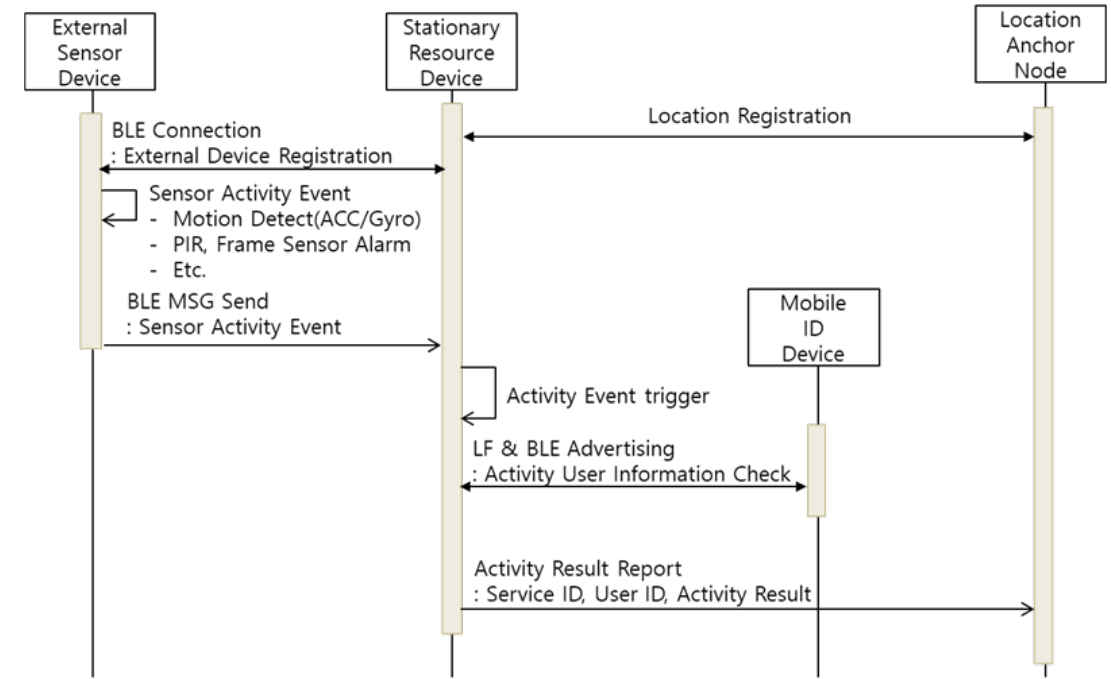
Figure 10. Sequence Diagram of Activity Event Report (External Sensor Device).